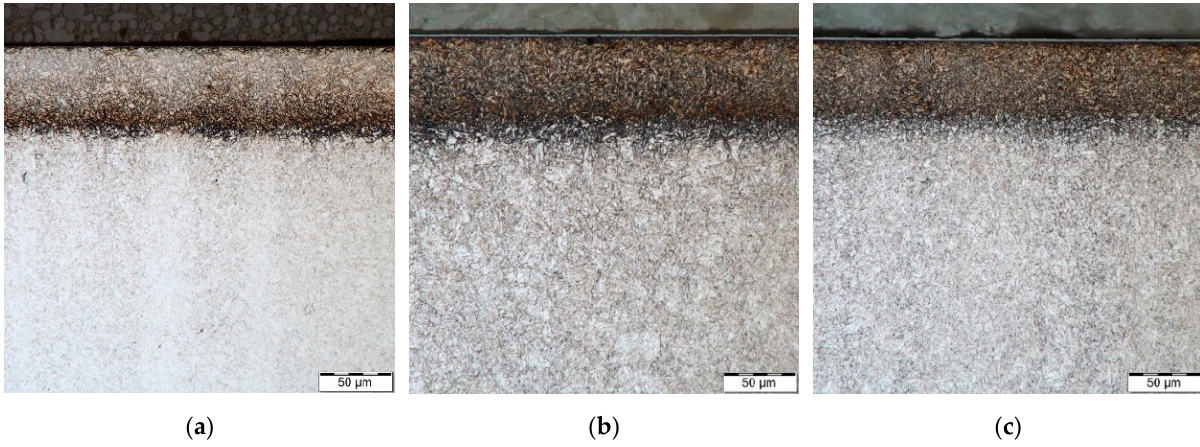
Figure 3. Microstructure optically observed with magnification 1000× on the steel H13 samples cross sections: ( a ) PN material; ( b ) PN/AlCrBN material; ( c ) PN/AlCrVN material.